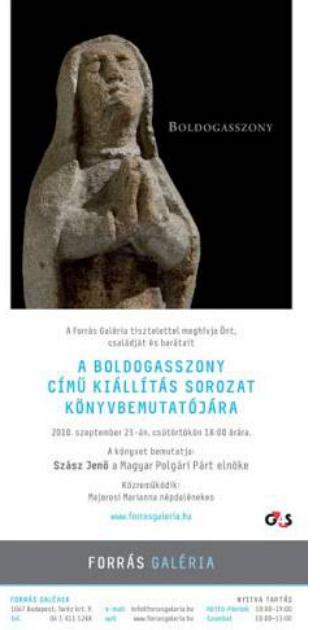
Figure 8. Invitation to Boldogasszony Exhibition Opening. Fekete applauded the exhibition’s emphasis on rebirth during its 2015 opening at Budapest’s state-owned Garden Bazaar gallery, since the space itself had been recently renovated—“reborn,” in his words—as part of the right-wing Hungarian government’s urban redevelopment plan, which sociologist Bence Kov á ts has criticized as the construc- tion of spectacle and “political commodification” of urban space (Kov á ts 2014). Like T ó th, Fekete emphasized the Virgin Mary’s symbolic role in representing the whole of Hungarian culture: “We want to serve the goal of reunifying the border-transcending nation by raising awareness of the cult of Mary in its role of representing Hungarian solidarity.” The artwork gathered together for “Blessed Lady” thus has a future-oriented and political purpose that aligns with the right-wing agenda of Hungary’s governing Fidesz party to establish for itself a leading position in the project of creating a border-transcending national cultural unity (See Figure